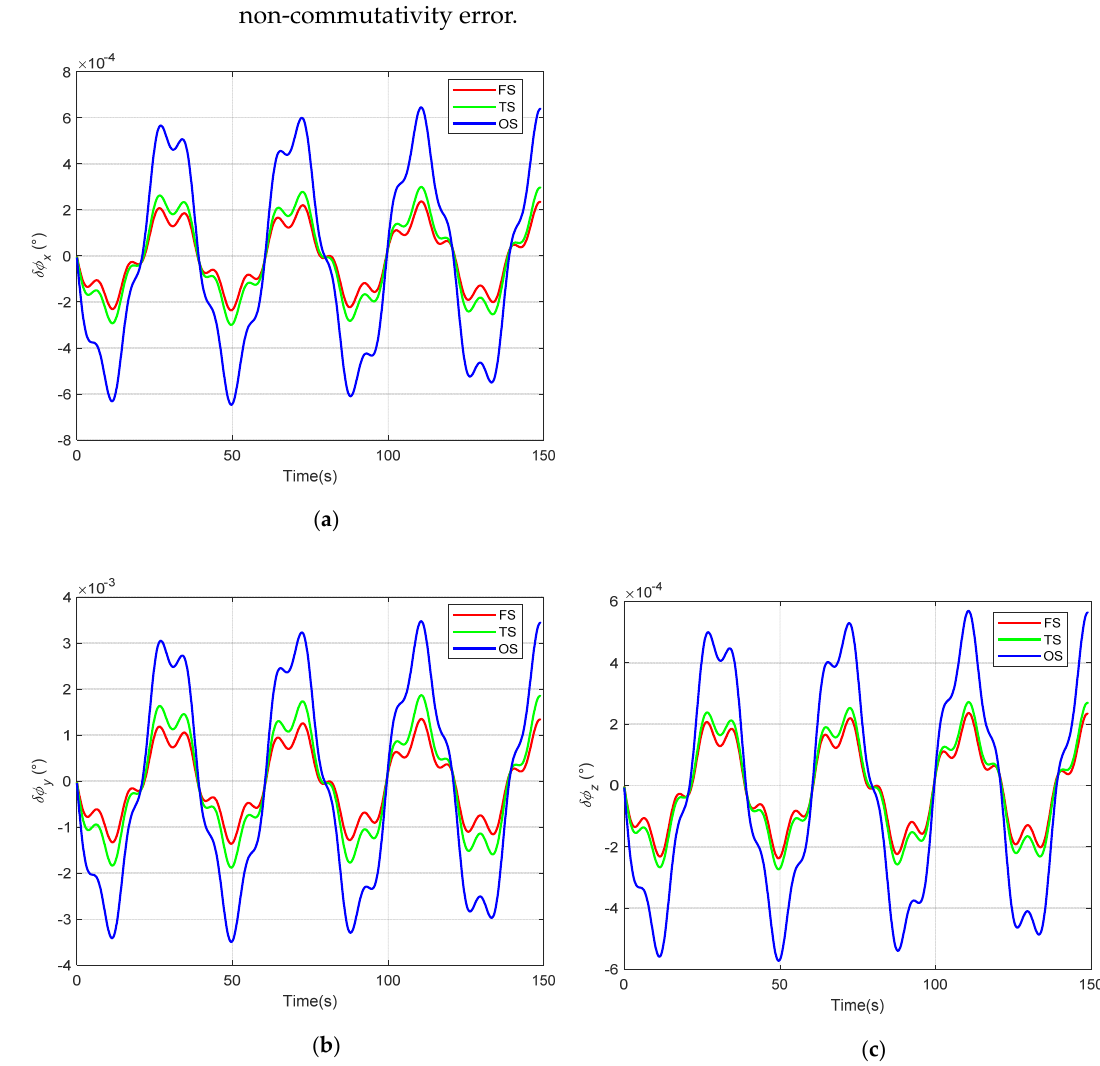
Figure 8. The coning error curve of SINS with the compensation algorithm of one-subsample (OS), three-subsample(TS), and four-subsample (FS): ( a ) the error curve in X-direction, ( b ) the error curve in Y-direction, ( c ) the error curve in Z-direction.